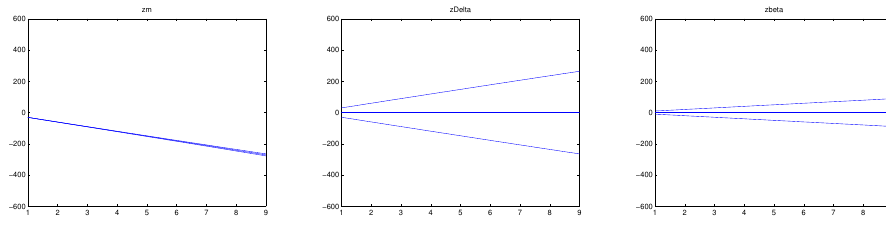
Fig. 17 Sensitivity of z with respect (left to right) the parameters m , ∆ and β .